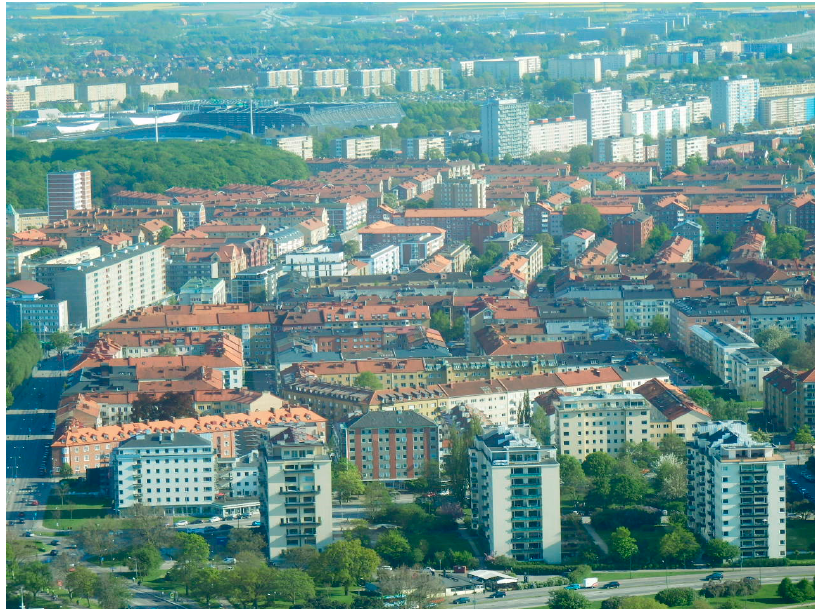
Figure 21. Walking and public transport-oriented neighbourhoods in Malmö in the foreground, with lower density areas in the distant background. Source: Jeffrey Kenworthy.